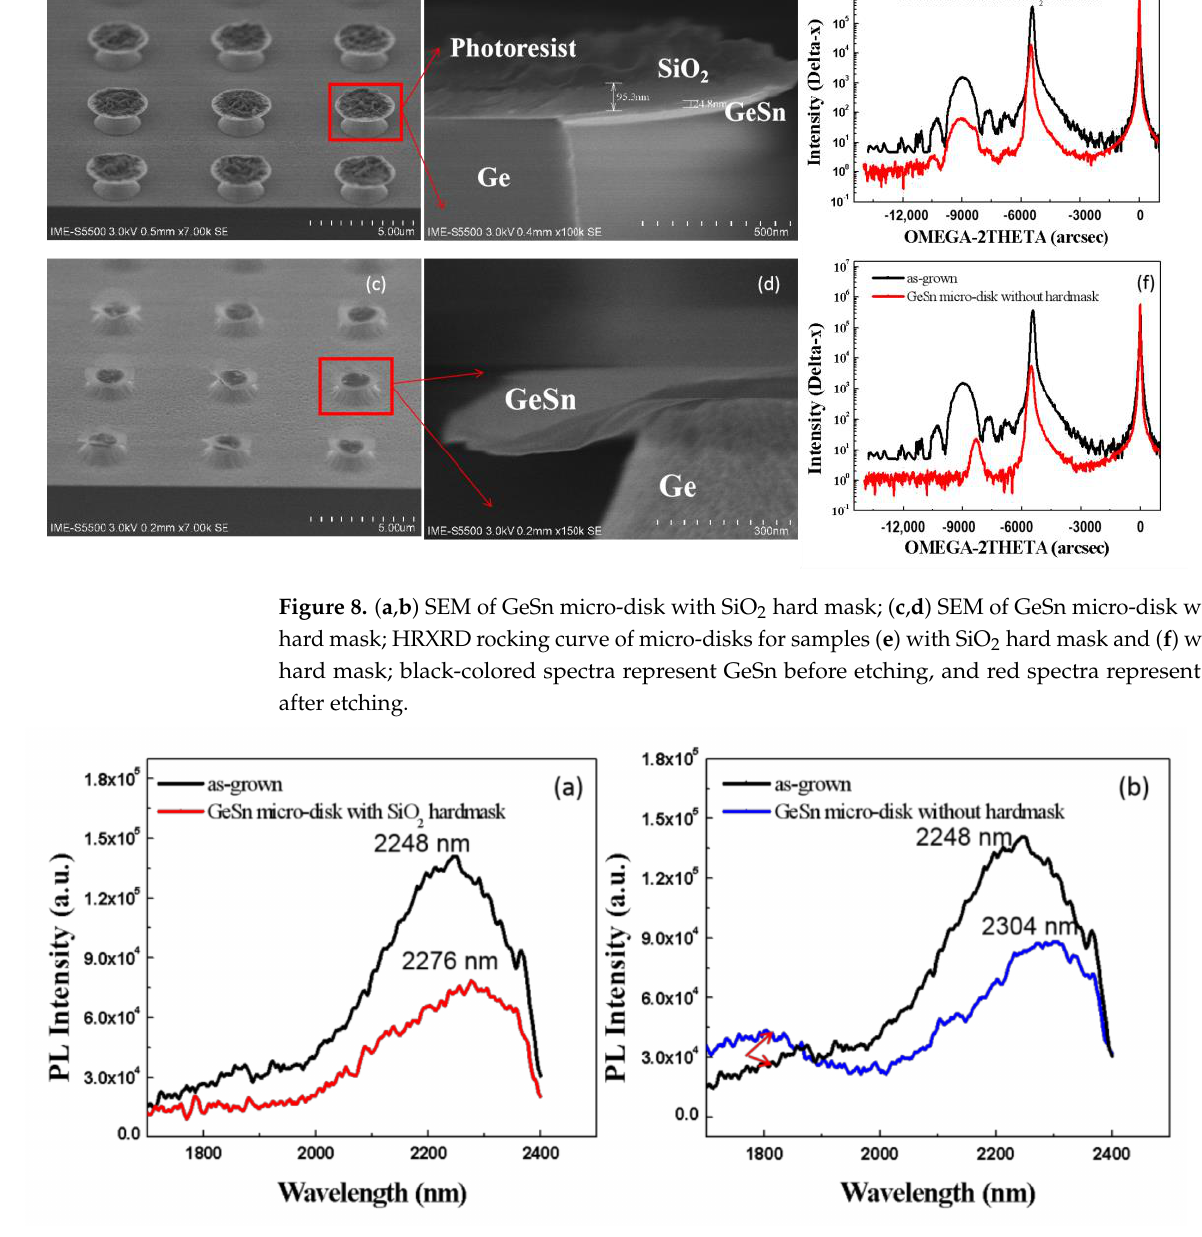
Figure 9. ( a ) PL of GeSn before etching (black line) and GeSn micro-disk with SiO 2 as hard mask (red line); ( b ) PL of GeSn as-grown (black line) and GeSn micro-disk without hard